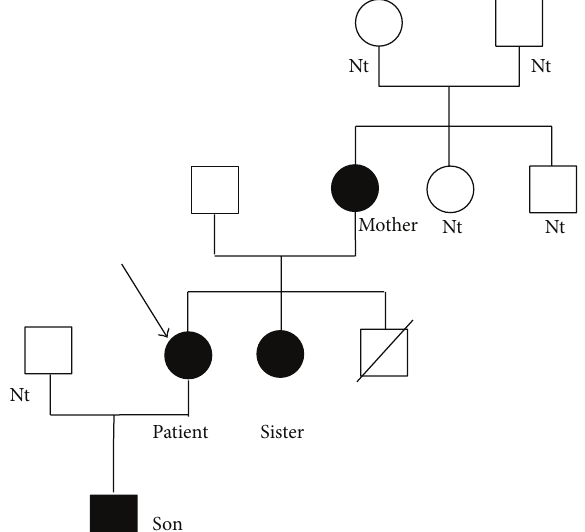
Figure 1: Pedigree of the proband’s family. Squares indicate males andcirclesfemales.Individualswith SCNN1B mutationareshownas filled figures. The proband is indicated by the arrow. Nt: not